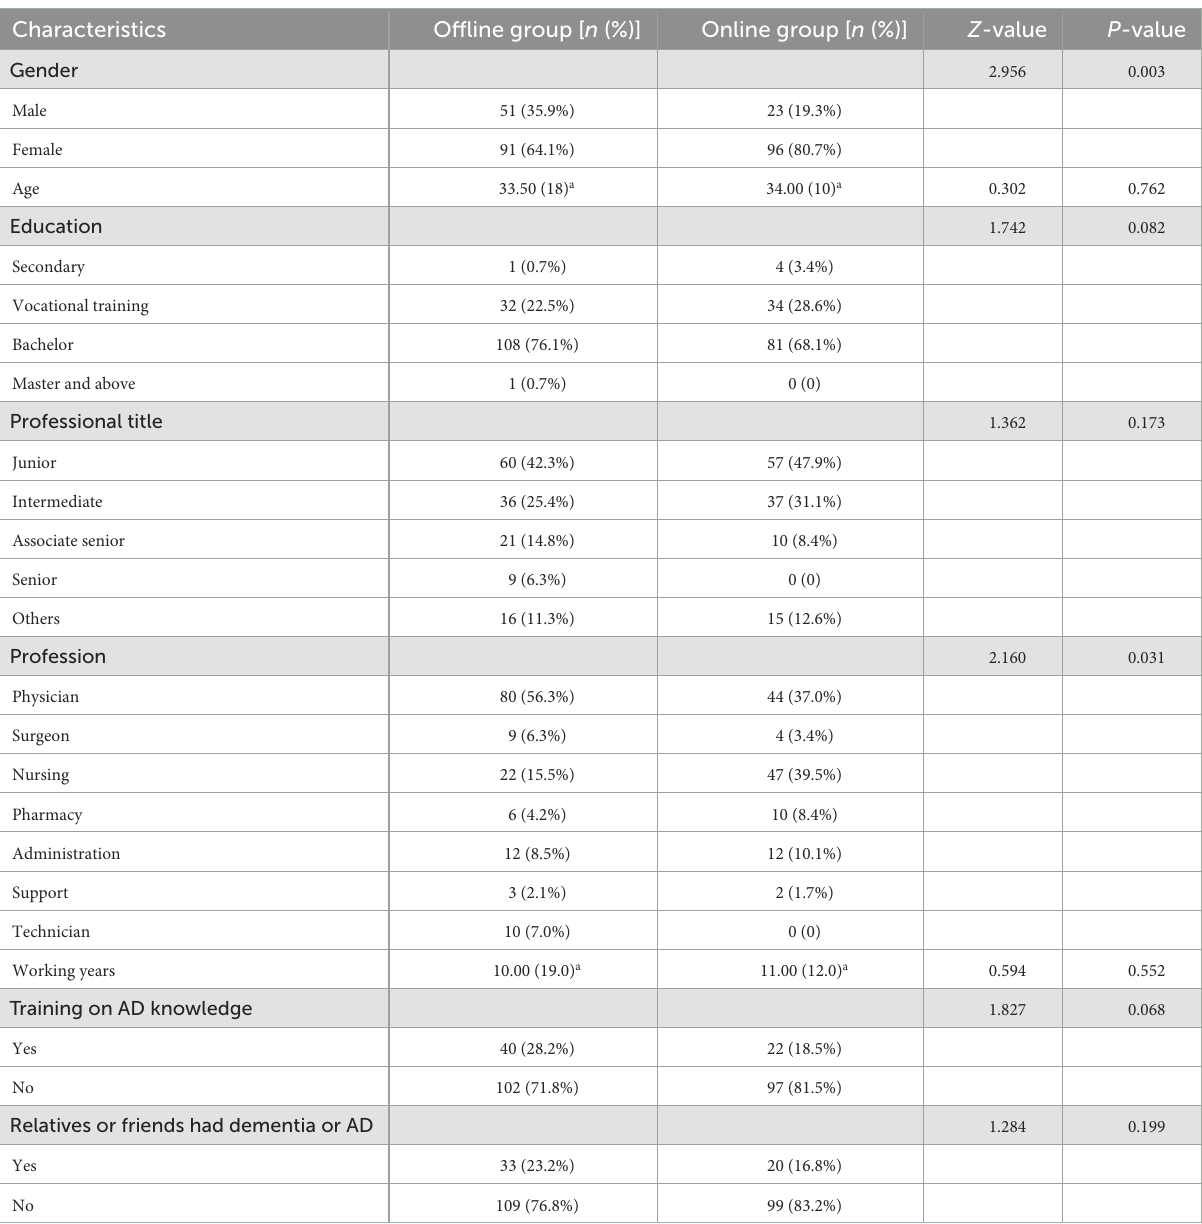
TABLE 3 Sociodemographic characteristics of the two groups.